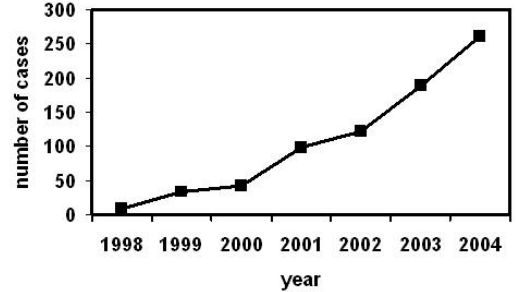
Fig. 2– NumberofhumancasesregisteredattheEvandroChagas Research Institute between 1998 and